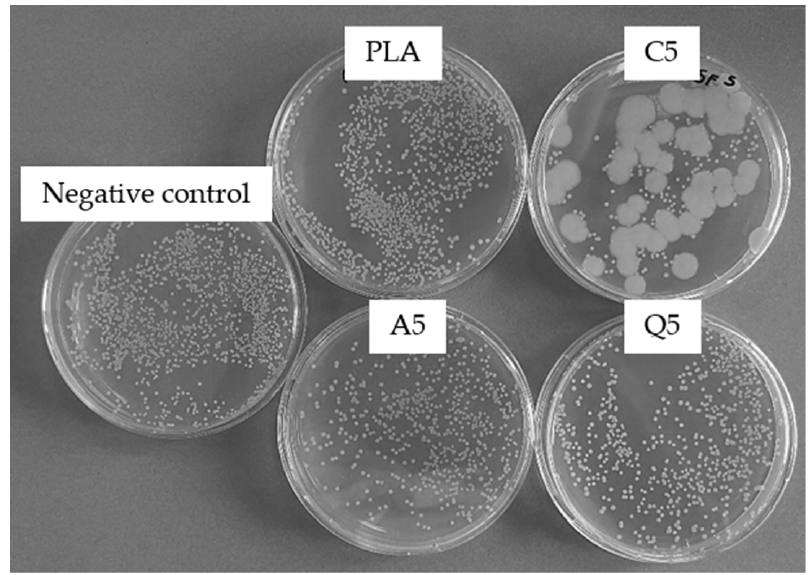
Figure 22. Antibacterial activity of melt-electrospun webs of pure PLA or PLA composites containing 5% ( w / w ) of alizarin (A5), curcumin (C5), or quercetin (Q5) against S. aureus at a 10 − 5 dilution.